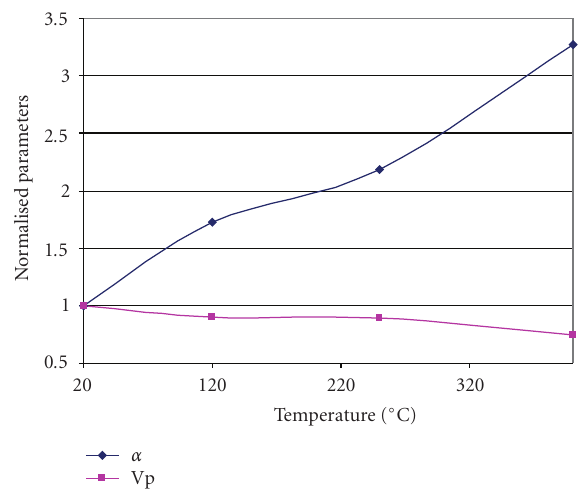
Figure 5: Relative variation of the nonlinear parameter α and of the velocity V p of pressure waves as a function of the damage